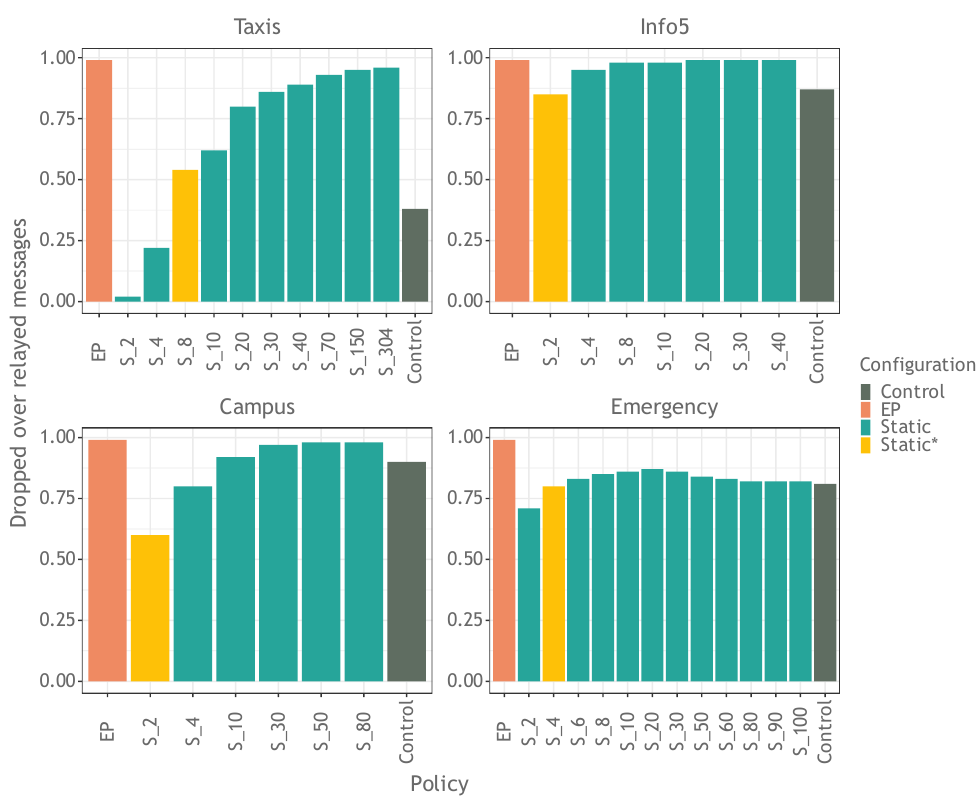
Figure 8. Percentage of dropped versus relayed messages by the different policies. The Static suffix denotes the replication limit. In the legend, the configuration named Static* corresponds to the Static configuration with the replication limit that the Control tends